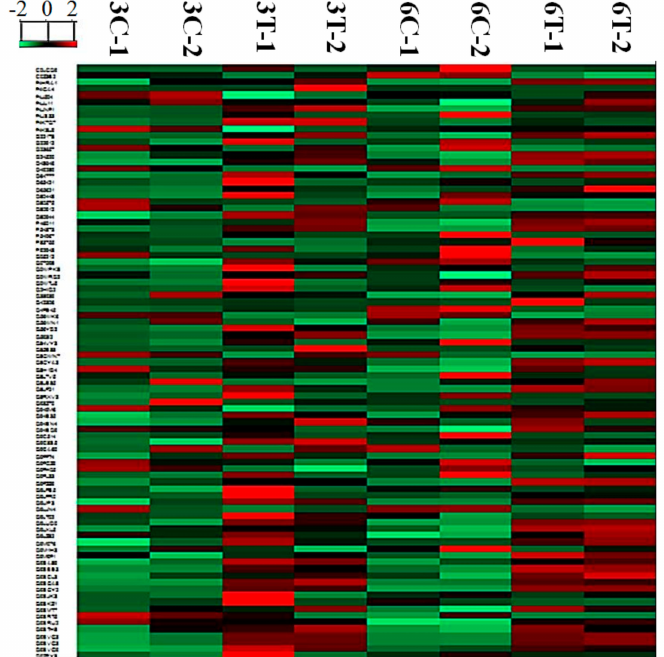
Figure 3. Heatmap of statistically-changed proteins identified based on Arabidopsis thaliana database. High- and low-expression are shown in green and red; C and T indicate control and PSF-treated,